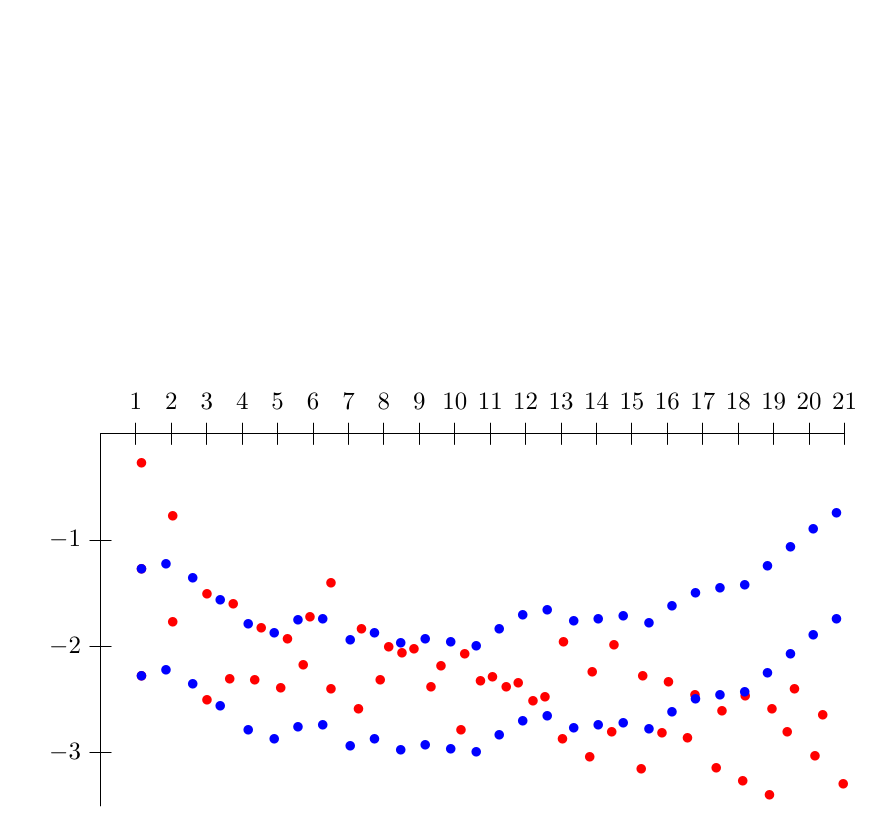
Figure H.1: For each s ∈ { 1 , 2 , . . . , 56 } : red dot at ( b, s − 2 . 8283396 b ) where b is minimum p log R 2 + R 2 where R 0 is an odd integer, R 1 is an even integer, and ( R 0 , R 1 ) requires ≥ s 2 0 1 iterations of divstep. For each s ∈ { 1 , 2 , . . . , 58 } : blue dot at ( b, s − 2 . 8283396 b ) where b is p minimum log R 2 + R 2 where R 0 is an odd integer, R 1 is an even integer, and ( R 0 , R 1 ) 2 0 1 requires ≥ s iterations of